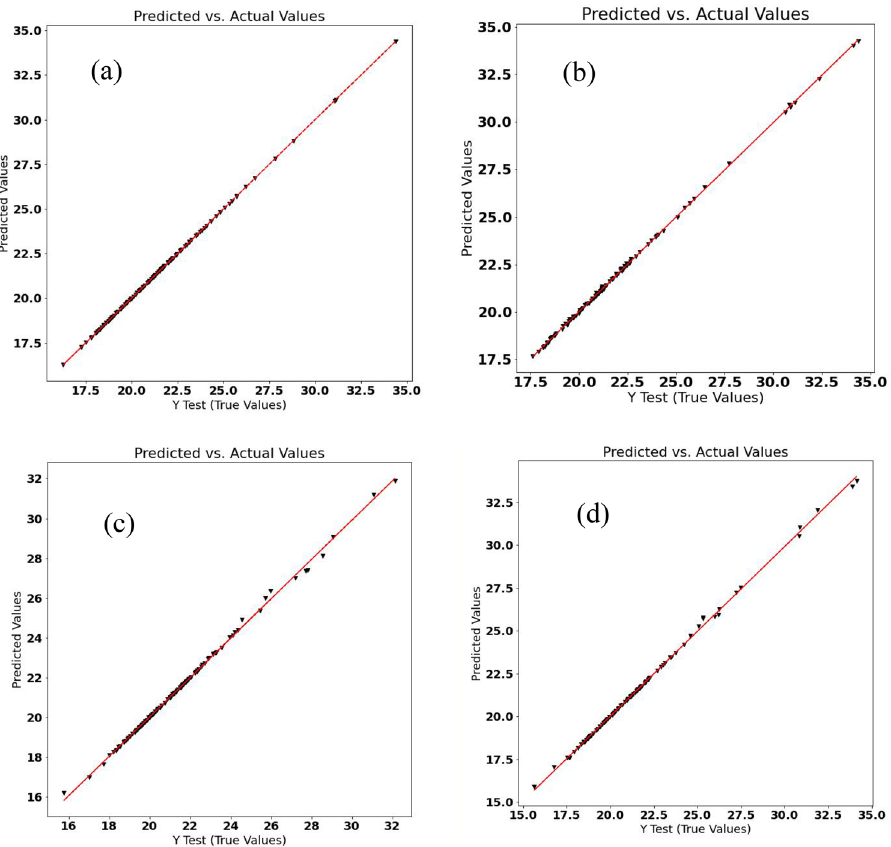
Figure 6. ( a ) Linear ( b ) Support vector, ( c ) Random forest, and ( d ) gradient boosting regressions of the protein percentage of the Lallemantia iberica ecotypes.